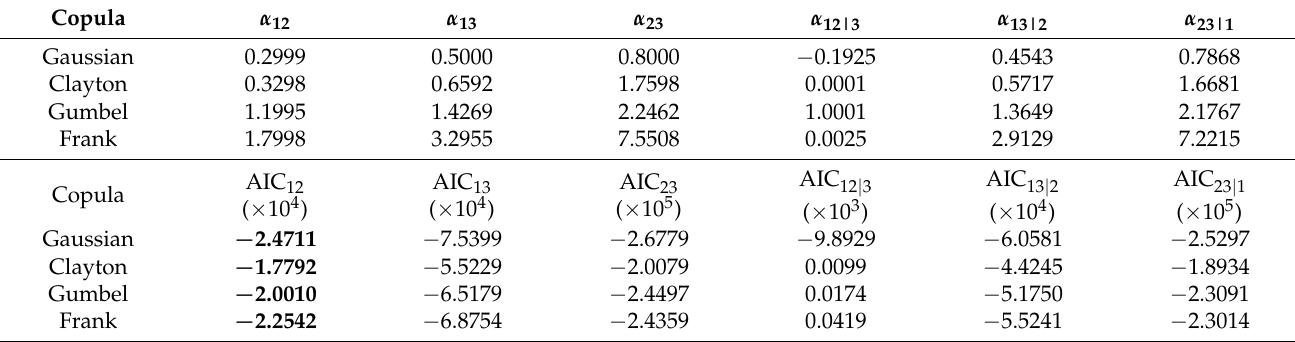
Table 2. The results of parameter estimation and AIC